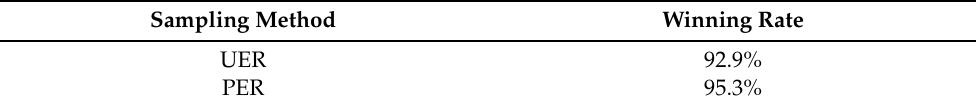
Table 5. The analysis of MC experiments for the trained results of UER-DDPG and PER-DDPG.